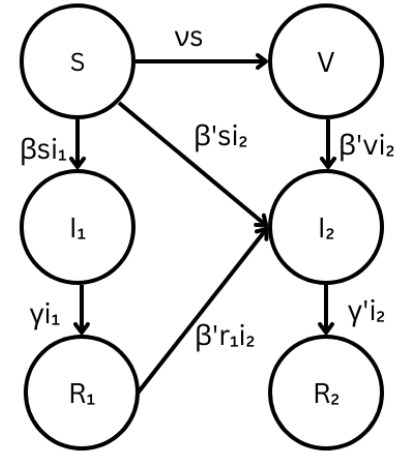
Figure 1. The schematic diagram of the multi-strain SIR model for emerging viral diseases with cross-immunity. The diagram includes the compartments and transition rates between compartments. Definitions of the transition coefficients are available in Table A1.